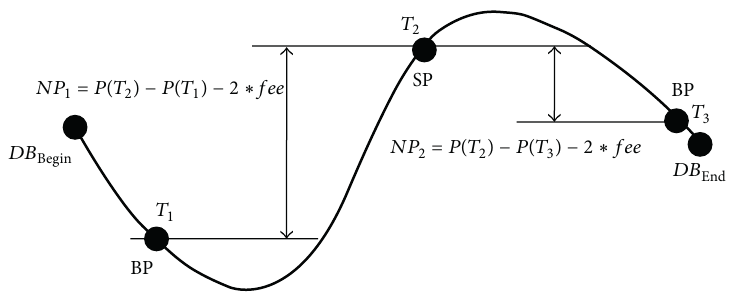
Figure 2: A stock price versus trading time curve for computing the profit of a trading